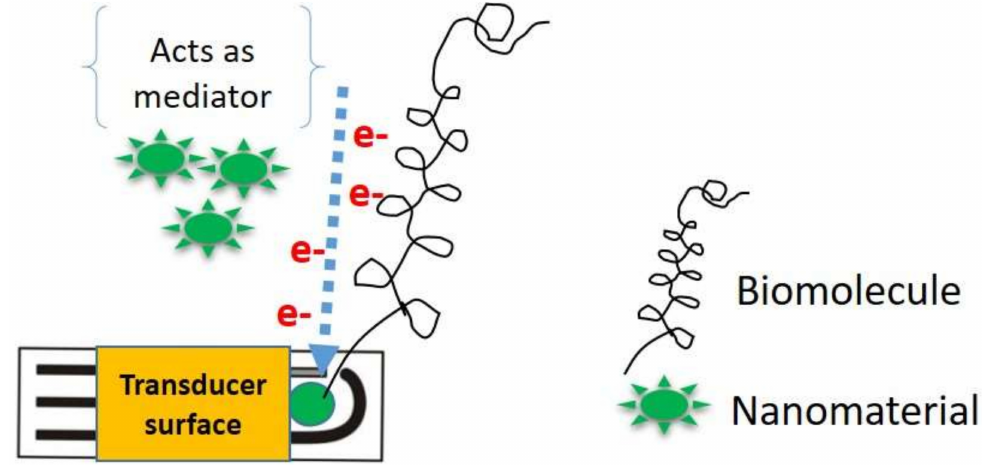
Figure 2. Nanomaterials as mediators in electrochemical